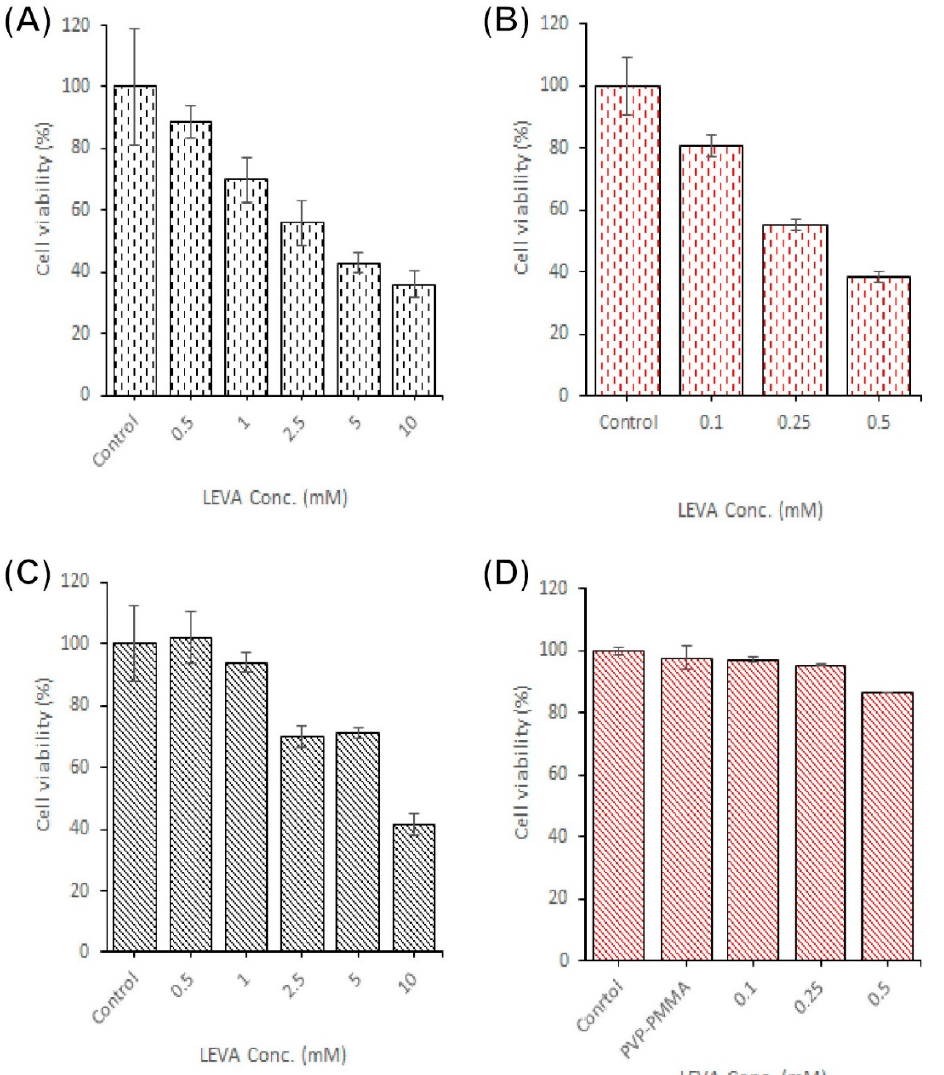
Figure 9. Cell viability of SKOV-3 and CP70 after being treated with a series of different concentration of ( A , B ) free form LEVA toward SKOV-3 and CP70, respectively. ( C , D ) CD133-conjugated Leva/PVP/PMMA MPs toward SKOV-3 and CP70, respectively. The results of quantitative analyses of the cytotoxicity of the aforementioned formulations against SKOV-3 and CP70 were determined by the MTT assays.